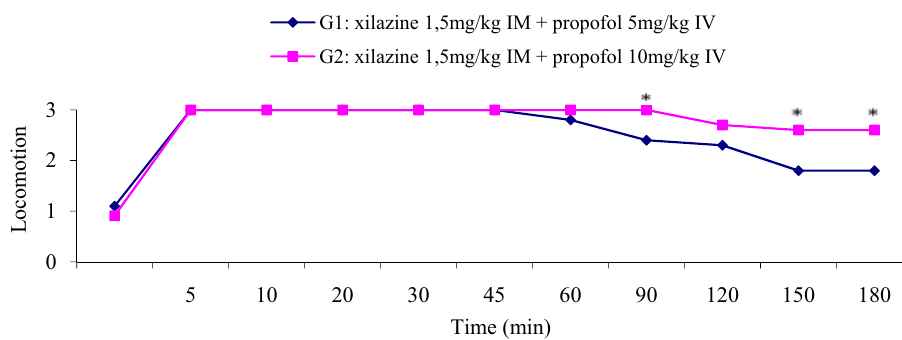
FIGURE 2 – Average scores of locomotion at different times, in P. expansa anesthetized with 1.5 mg/kg IM of xylazine and 5 mg/kg IV of propofol, and with 1.5 mg/kg IM of xylazine and 10 mg/kg IV of propofol. The asterisks (*) indicate significant differences between the groups (p <